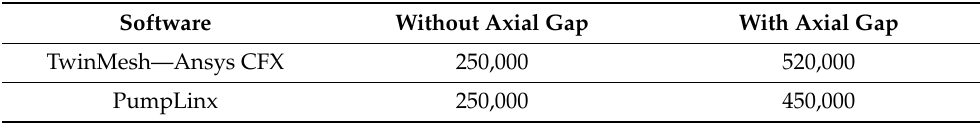
Table 1. Number of grid nodes in the different